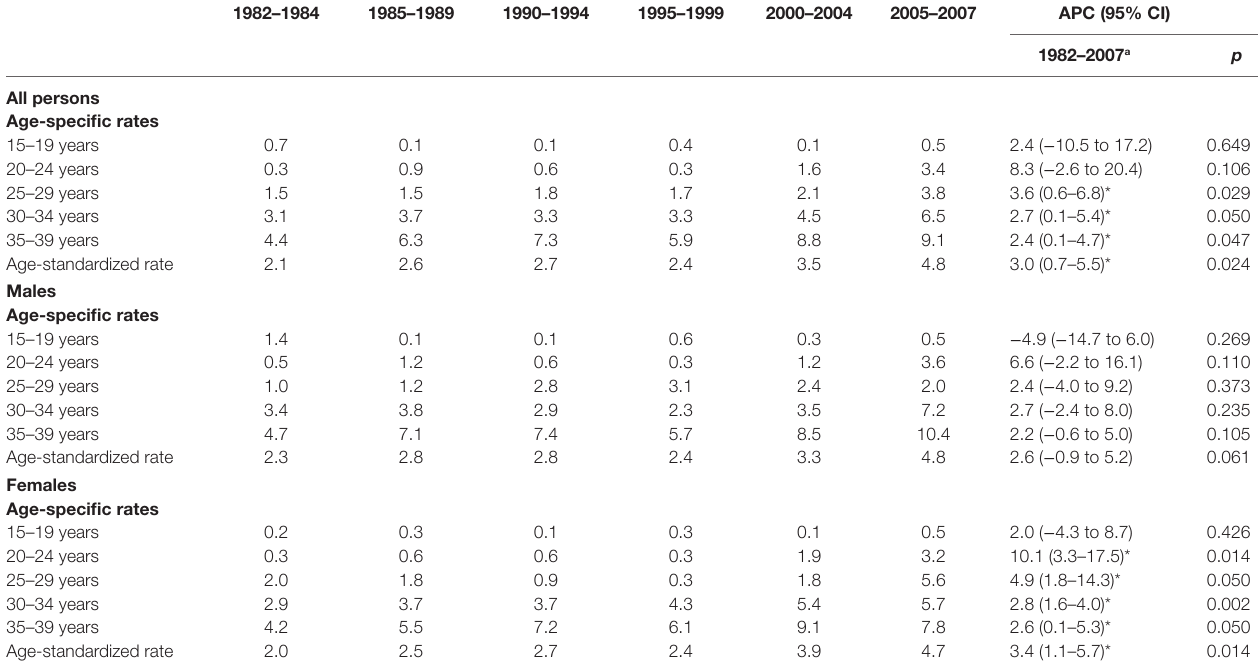
Table 1 | Five-year age-specific and age-standardized and Joinpoint analysis of annual colorectal cancer incidence rates per 100,000 in adolescents and young adults aged 15–39 years in Western Australia during